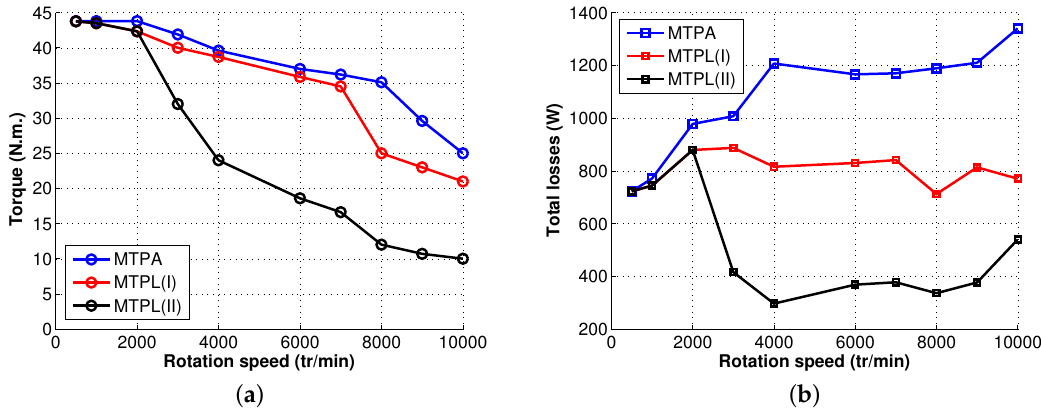
Figure 8. Comparison between the three control strategies: ( a ) torque; ( b ) total